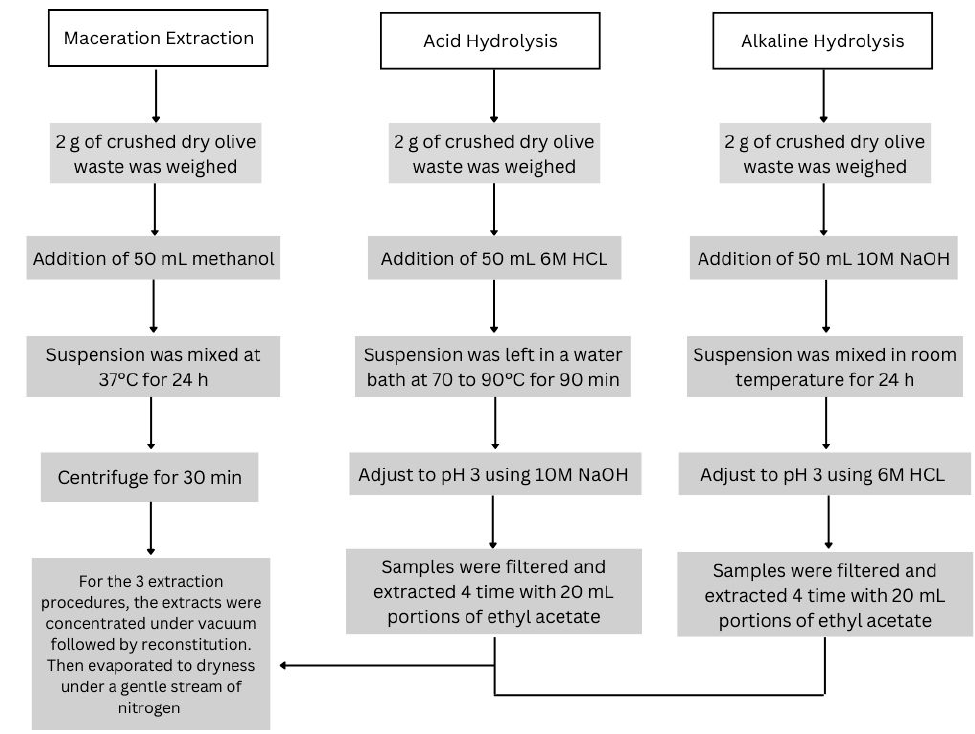
Figure 1. Extraction procedure for maceration extraction, acid hydrolysis and alkaline hydrolysis.